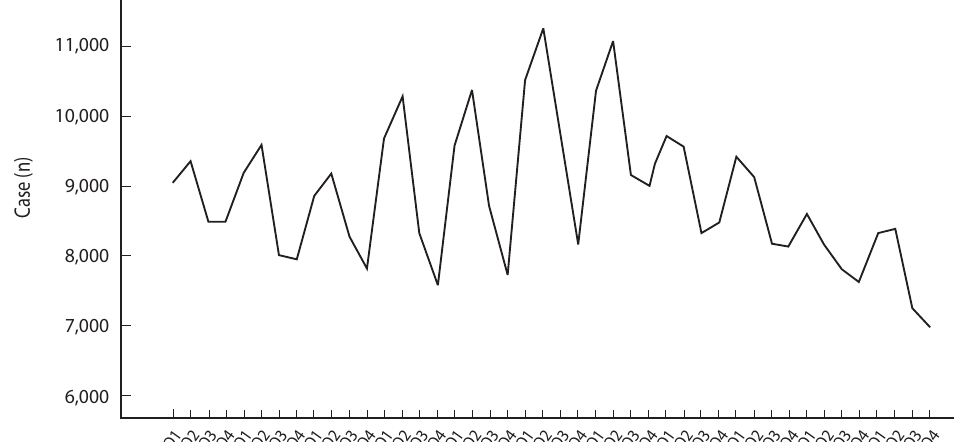
Figure 1. Seasonal notified tuberculosis cases, 2006-2016.